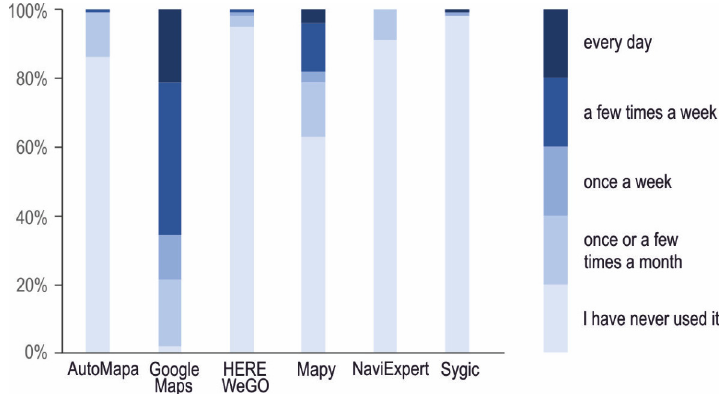
Fig. 2. Frequency of respondents’ use of analysed